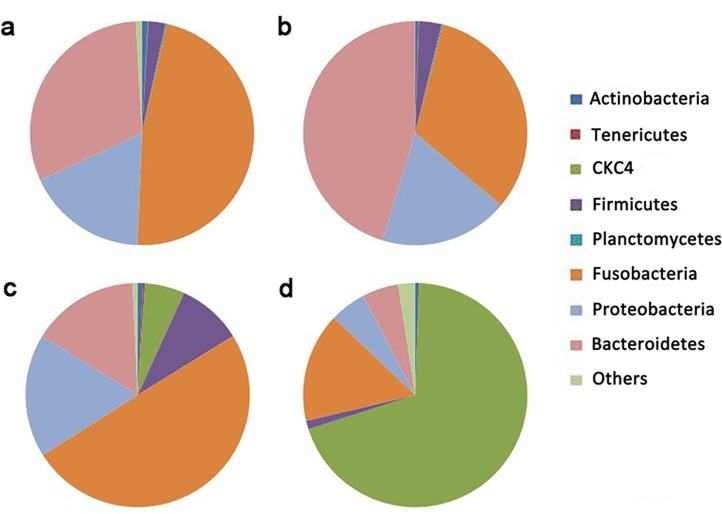
Intestinal microbiotic composition in zebrafish raised in different conditions.The pie charts represent the core microbiota of Group M (male) (a), Group F (female) (b), Group BPA (male treated with 2000 μg/L BPA) (c) and Group E2 (male treated with 2000 ng/L E2) (d).